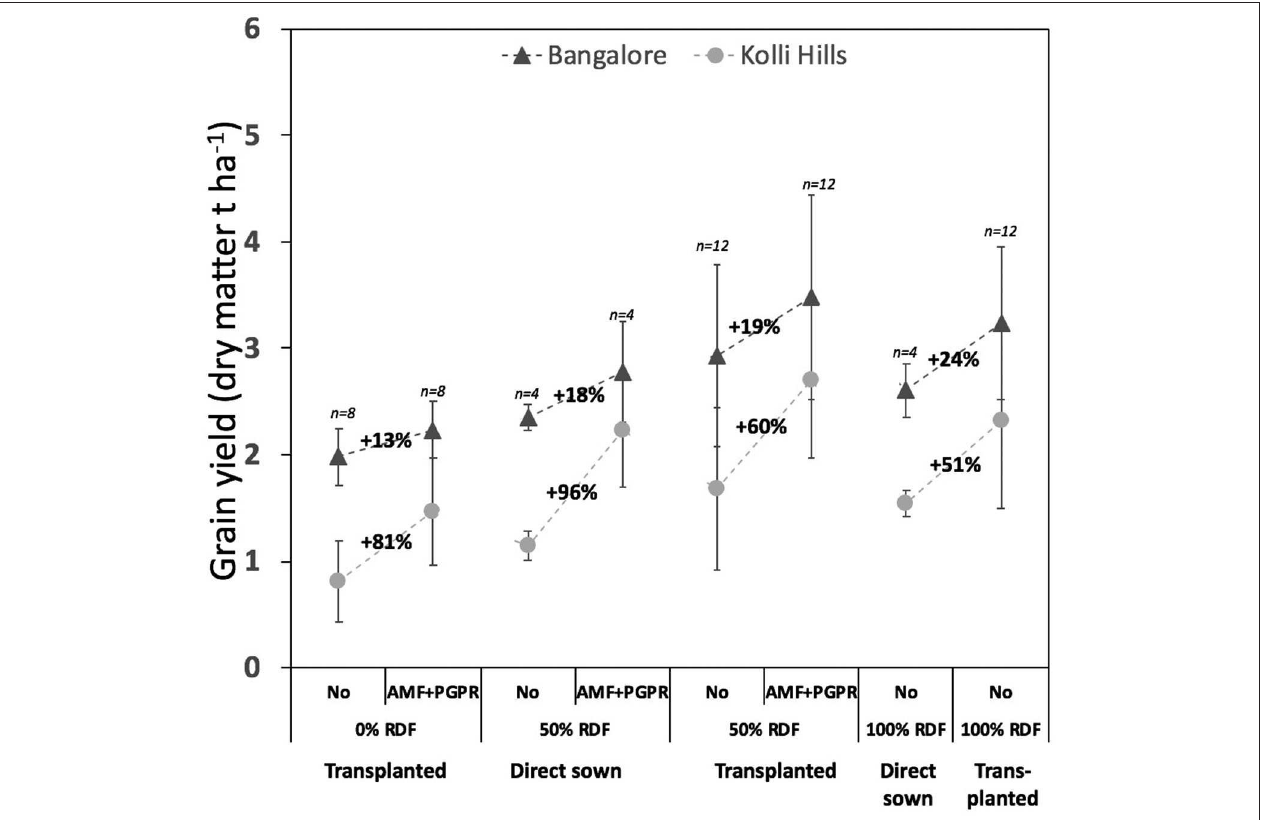
FIGURE 7 | Summary graph depicting potential of attaining higher grain yields of pigeon pea and finger millet in two sites under three mineral fertilizer levels and two different sowing systems through application of AMF + PGPR. Each error bar indicates ± 1 standard deviation of the mean. Dotted lines connecting two points are used only for the purpose to indicate the trend for better visualization of the effects of inoculation. Bangalore, site with high inherent soil fertility; Kolli Hills, site with low inherent soil fertility. RDF, recommended dose of chemical fertilizers; no, no inoculation; AMF, arbuscular mycorrhizal fungi; PGPR, plant growth-promoting rhizobacteria; transplanted,